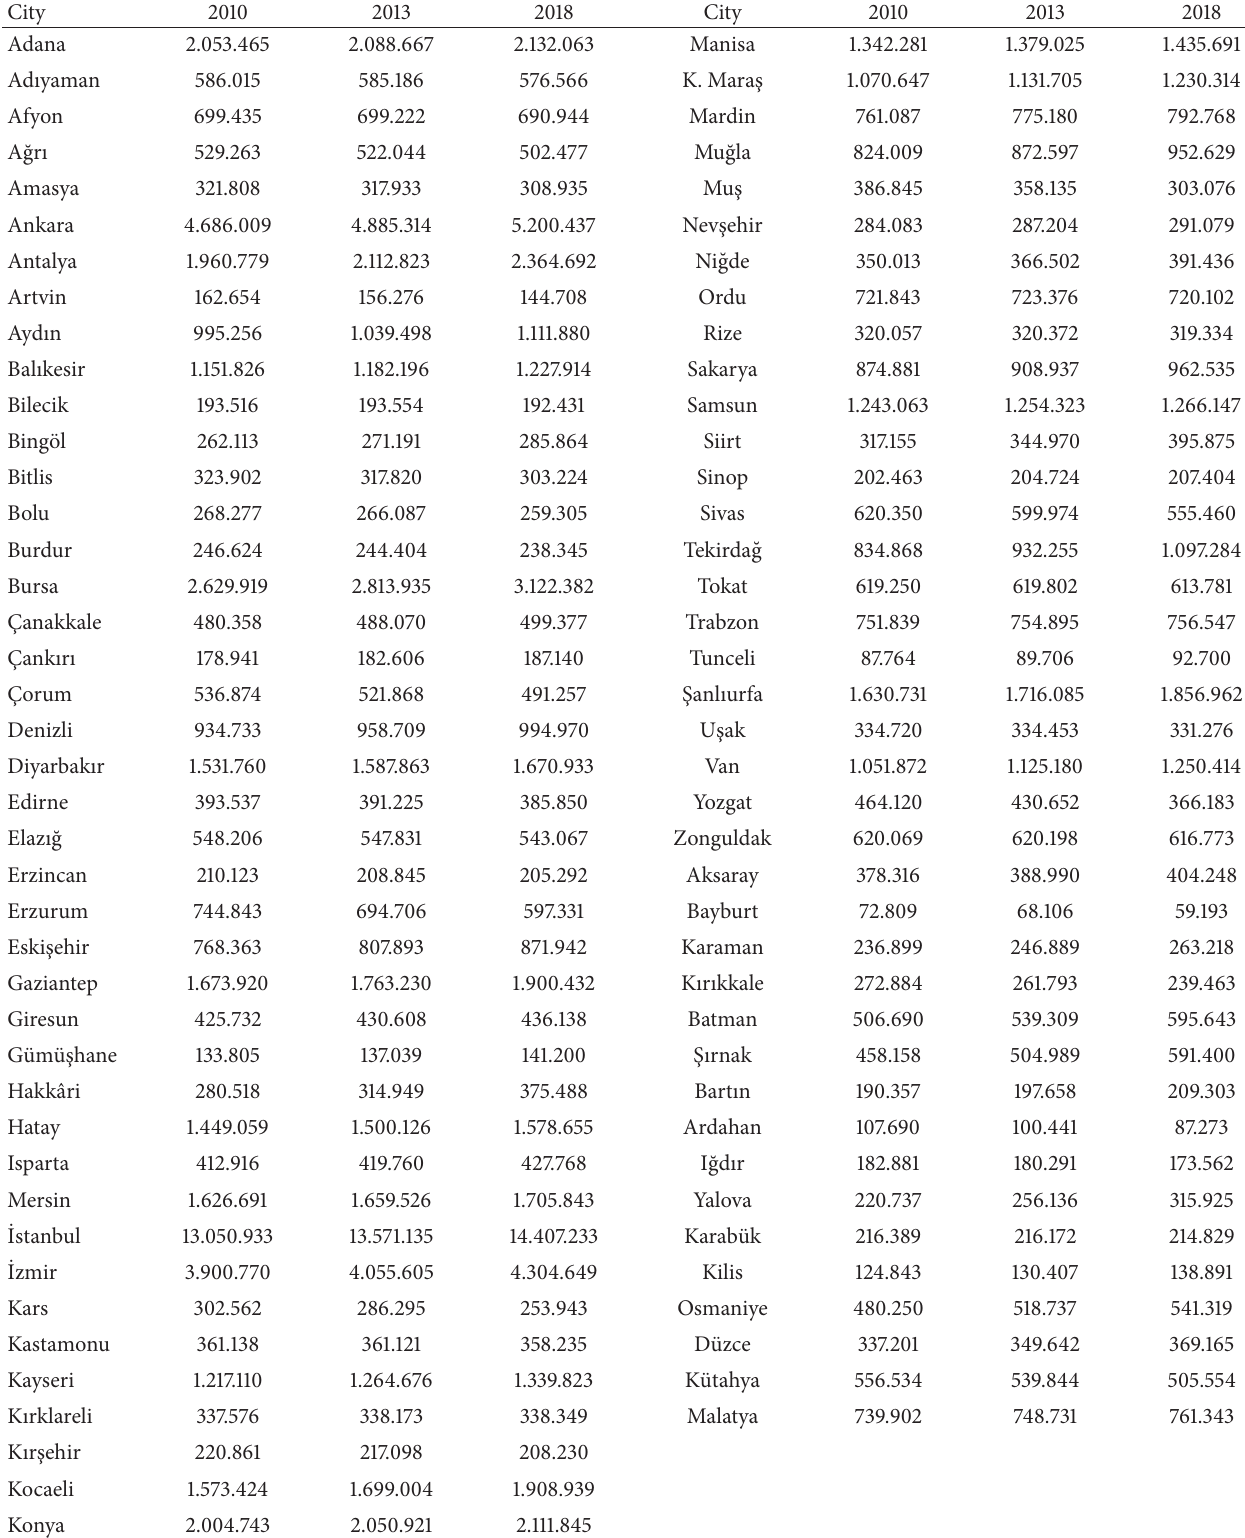
Table 6: Population and population